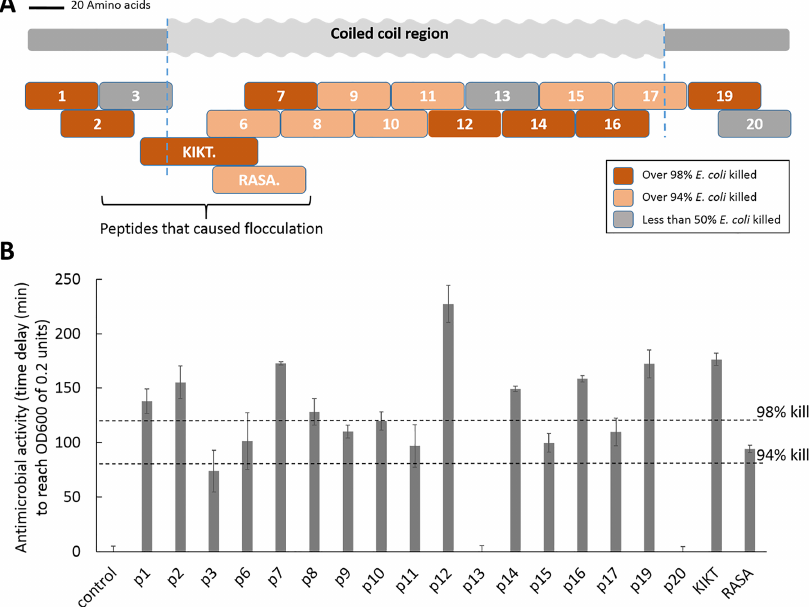
Fig 1. Testing the antimicrobial activity of peptides from the honeybee ( Apis mellifera ) silk protein AmelF3. A. Schematic showing where the peptides are located within the silk protein. Colors indicate strength of antimicrobial activity and a bracket identifies which peptides led to flocculation of the bacteria. The predicted coiled-coil region of the protein is indicated. B. Comparative antimicrobial activity of the various peptides expressed as the time delay (min) for an E . coli culture to reach an optical density at 600 nm (OD600) of 0.2 units. Dotted lines show the delay associated with 94 and 98% kill of the population. Error bars show the standard error of the mean calculated from four separate growth